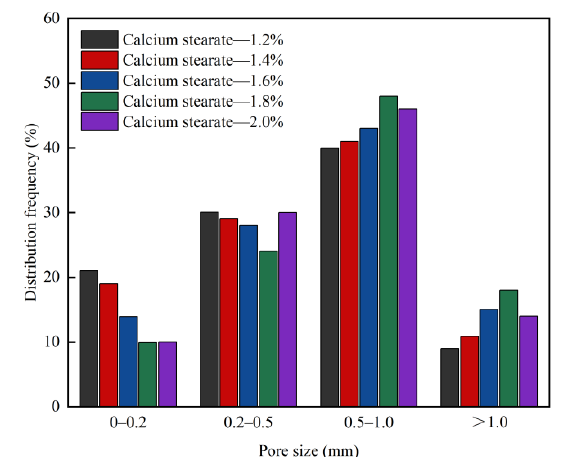
Figure 8. Effect of calcium stearate content on porosity of foam concrete.